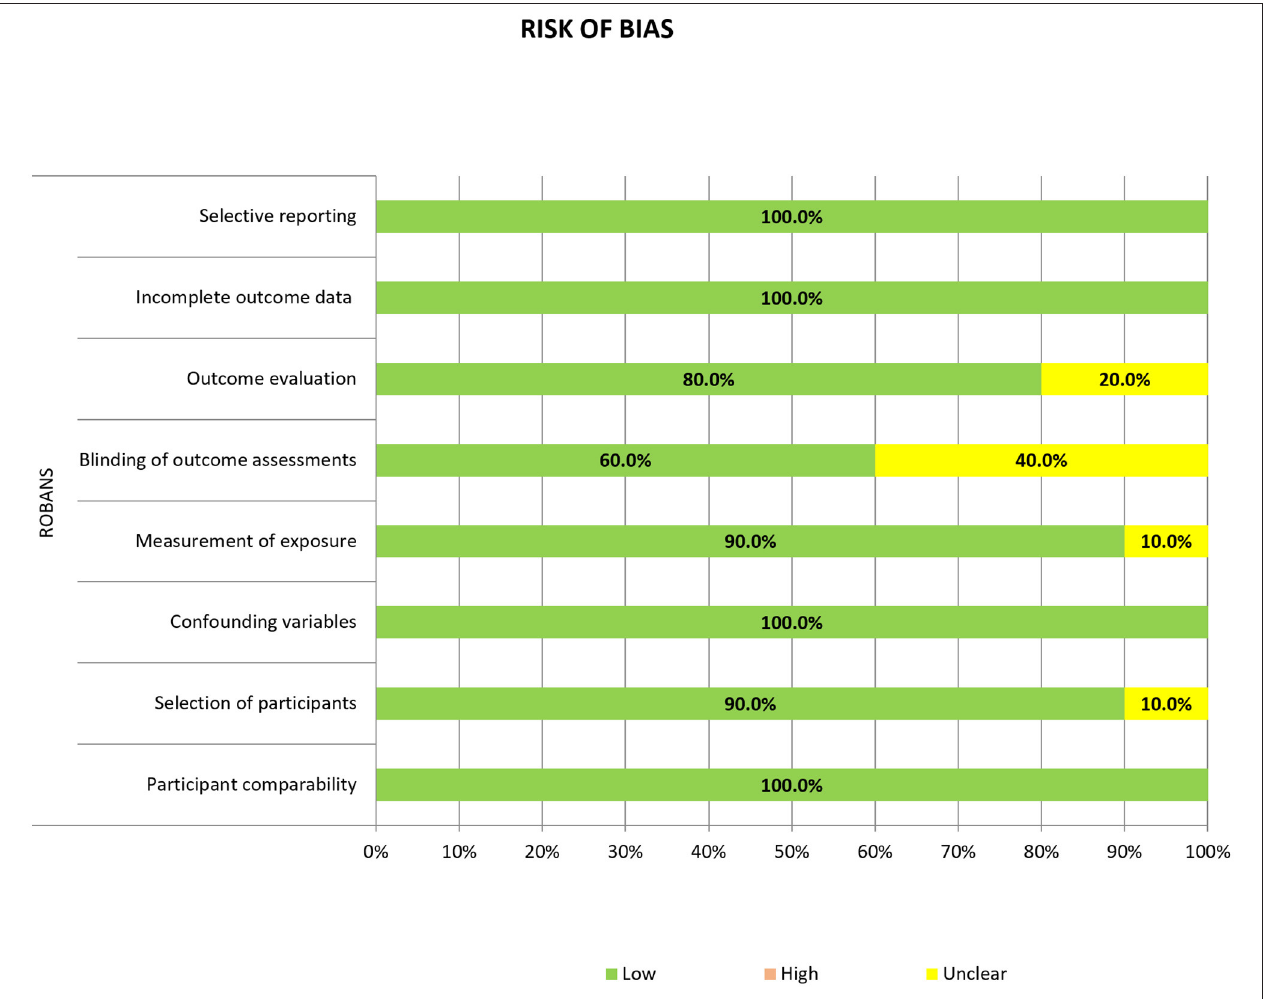
FIGURE 2 | Risk of bias